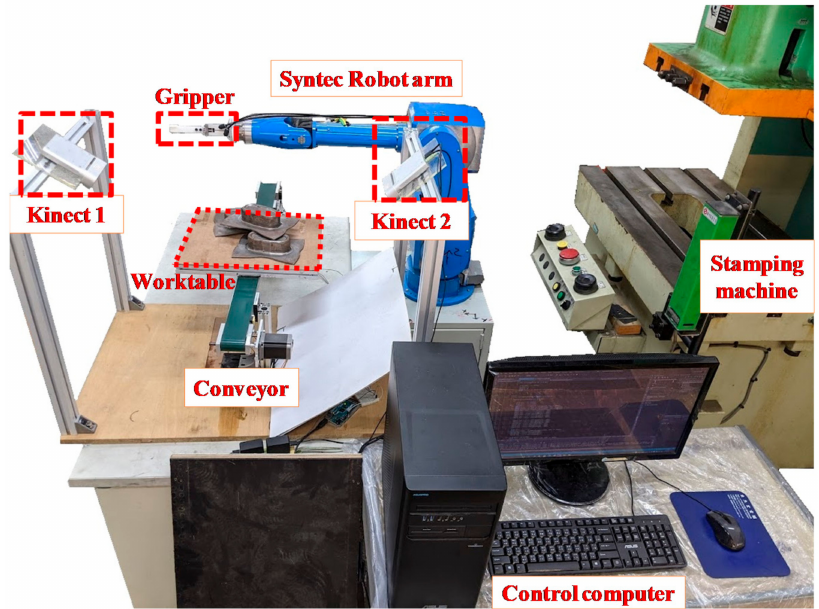
Figure 1. Experiment device setup of stereo vision scanning for dynamic workpiece.